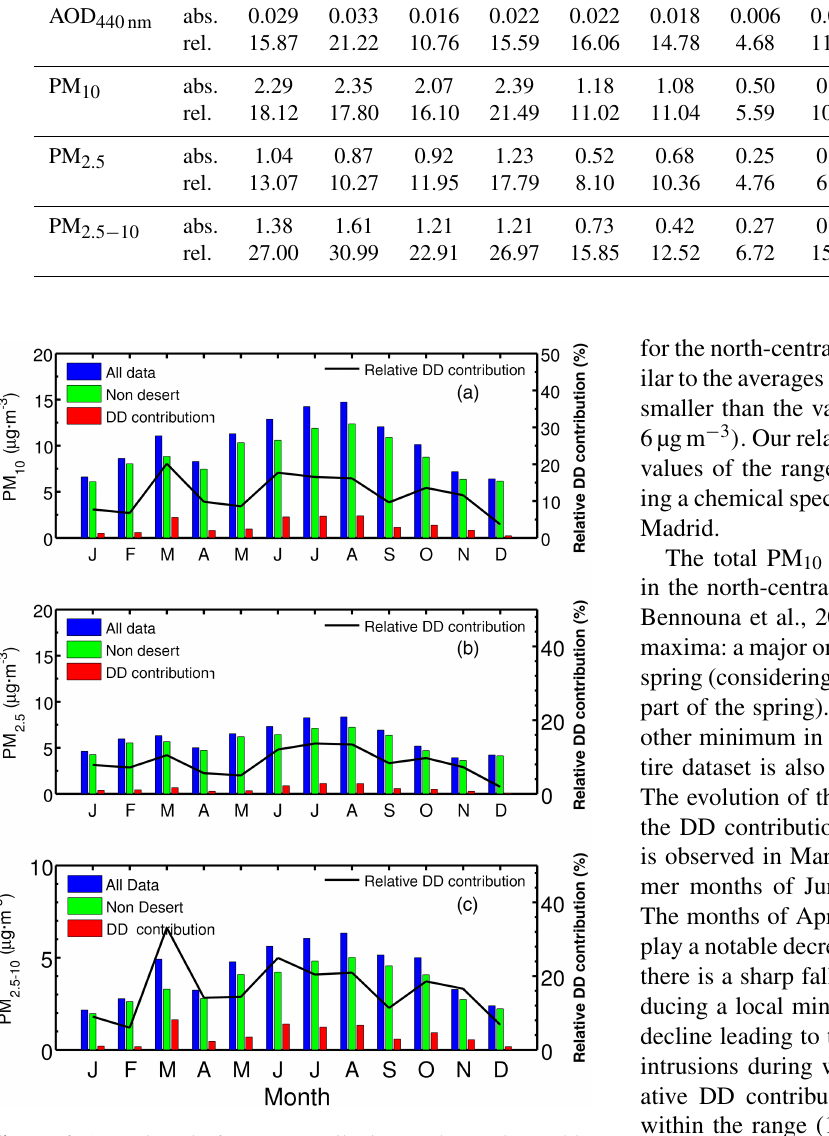
Figure 6. Annual cycle for DD contribution to the total monthly PM 10 (a) , PM 2 . 5 (b) , and PM 2 . 5 − 10 (c) means in absolute (red bar) and relative values (black line) in 2003–2014. Blue bars represent the annual cycle of total PM 10 (a) , PM 2 . 5 (b) , and PM 2 . 5 − 10 (c) and green bars the corresponding values without including the days of desert